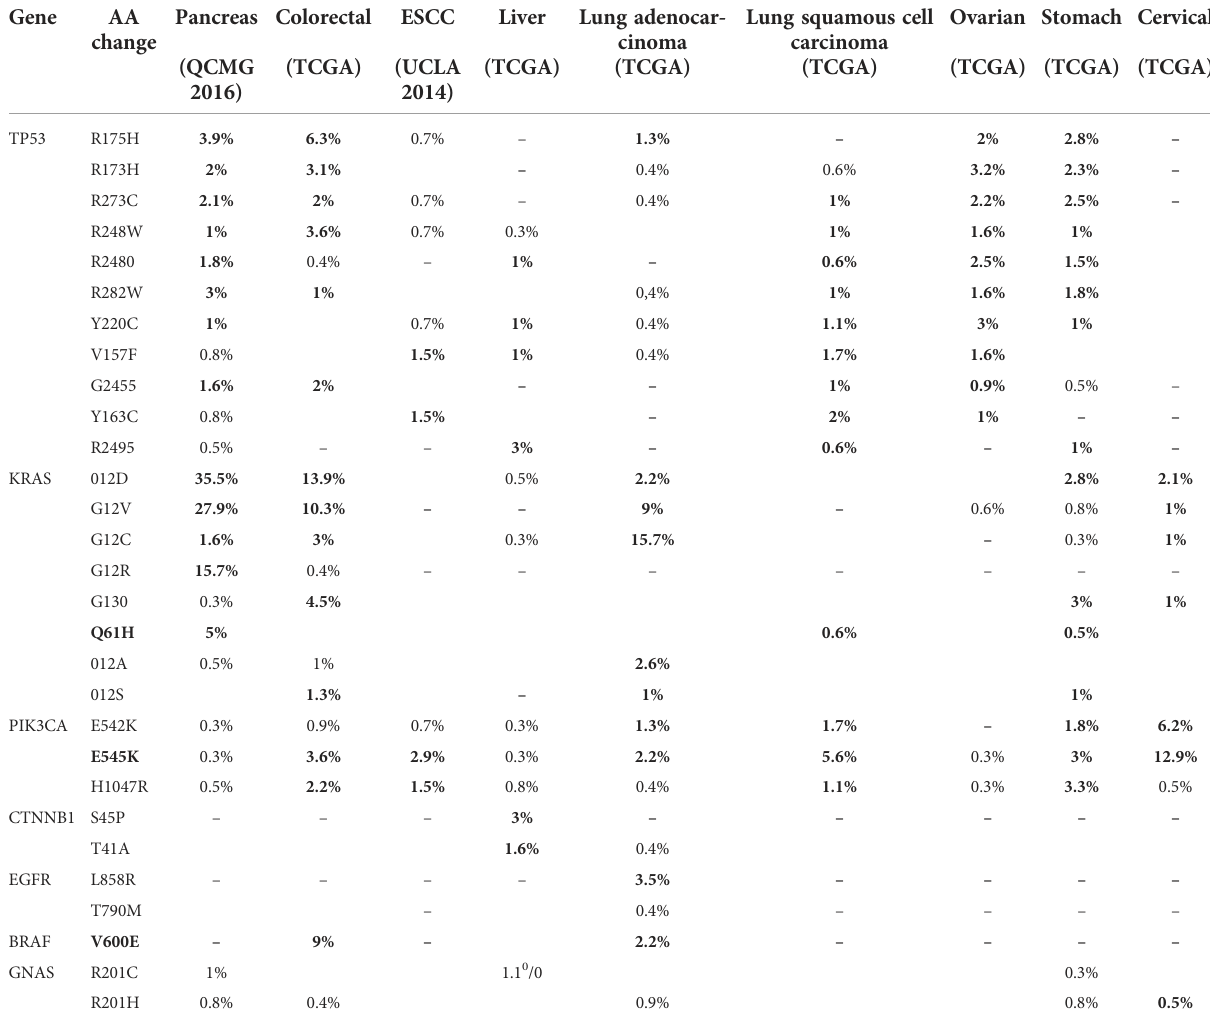
TABLE 2 Neo-antigen of common solid tumors